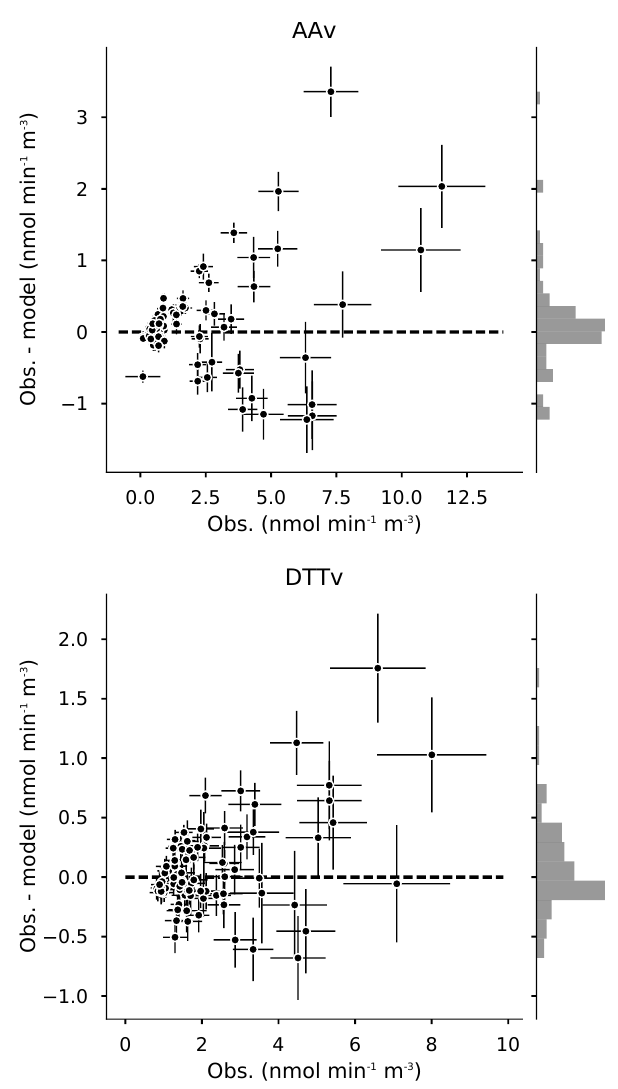
Figure 5. Residual distribution for the regression of the AA and DTT assays (85 samples). The error bars represent the standard de- viation of the observation and the model. The histogram on the right is the distribution of the residuals. Units are in OP normalized by volume and expressed in nmolmin − 1 m − 3 . Note the different scales for the AA v and the DTT v